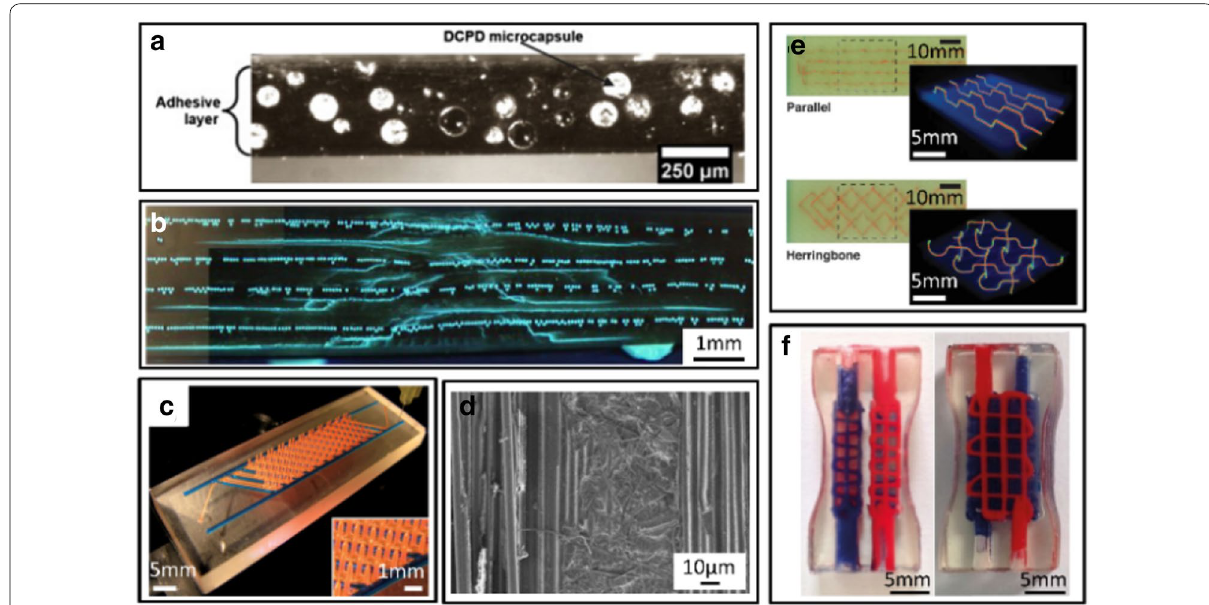
Figure 15 ( a ) The microcapsule structure in an adhesive layer observed by optical microscopy [123]; ( b ) The impact damaged cross section of a bio-inspired material with healing filaments [126]; ( c ) The microvascular network fabricated by assembly of organic ink [129]; ( d ) SEM micrograph of nanofiber interlayers fabricated by electrospinning [130]; ( e ) Prevascularized composite laminate samples; X-ray computed microtomographic reconstructions (top) of postvascularized vascular networks (bottom) [132]; ( f ) Representative image of epoxy-H samples